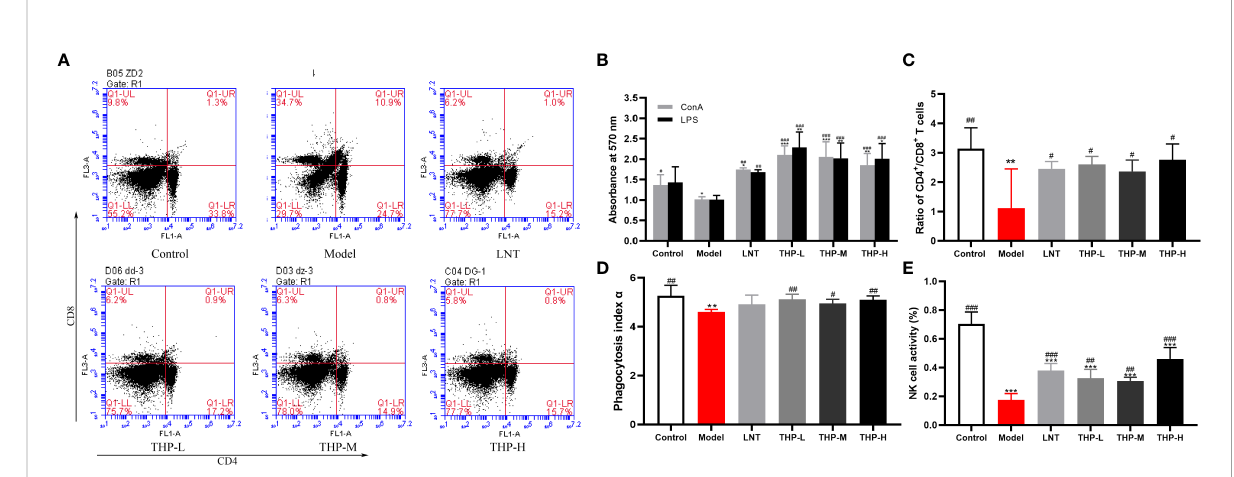
FIGURE 9 Effect of THP on CTX-induced immunosuppression through cellular immunity. (A) The proportion of splenic CD4 + CD8 + T cells was detected by fl ow cytometry. (B) The ratio of splenic CD4 + /CD8 + T cells. (C) Lymphocyte proliferation. (D) Phagocytic index a . (E) NK-cell activity. Each value is presented as the mean ± SD. *P < 0.05, **P < 0.01, ***P < 0.001 versus Control; # P < 0.05, ## P < 0.01, ### P < 0.001 versus